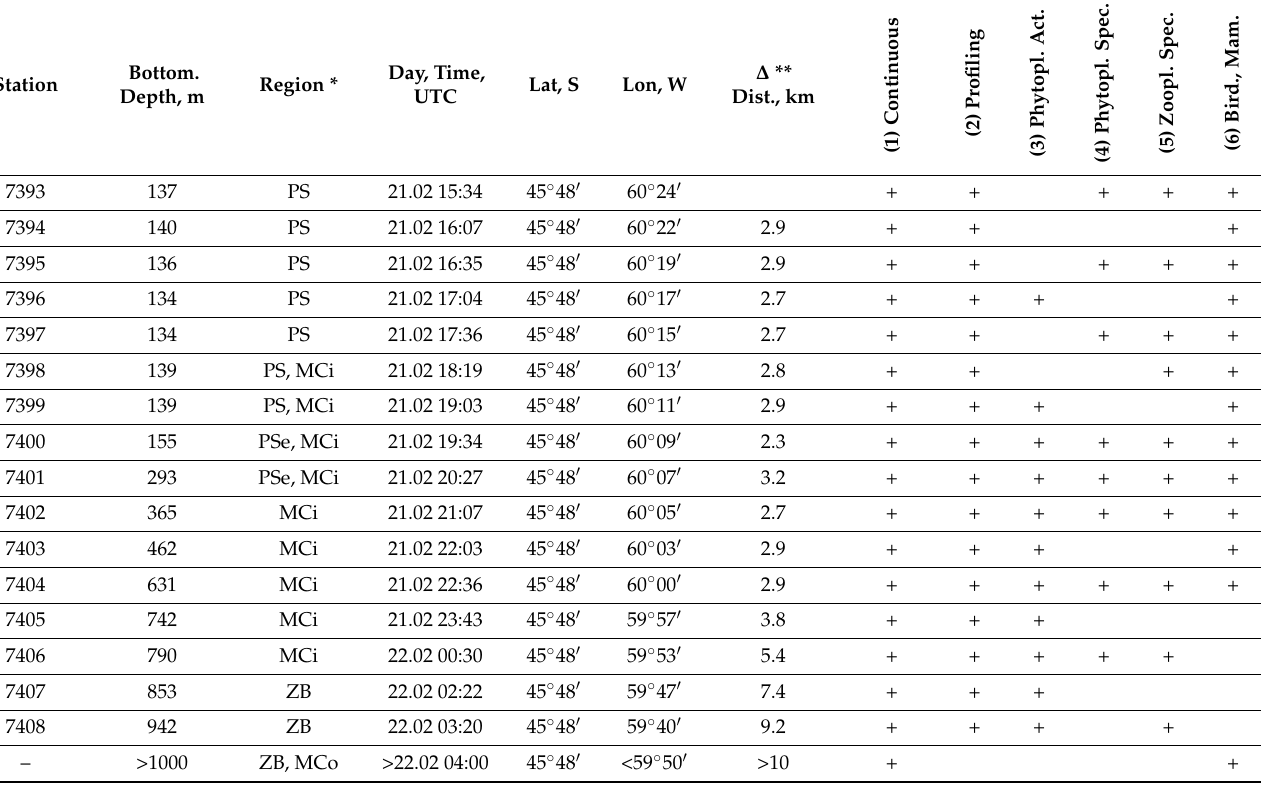
Table 1. Summary of completed oceanographic and biological